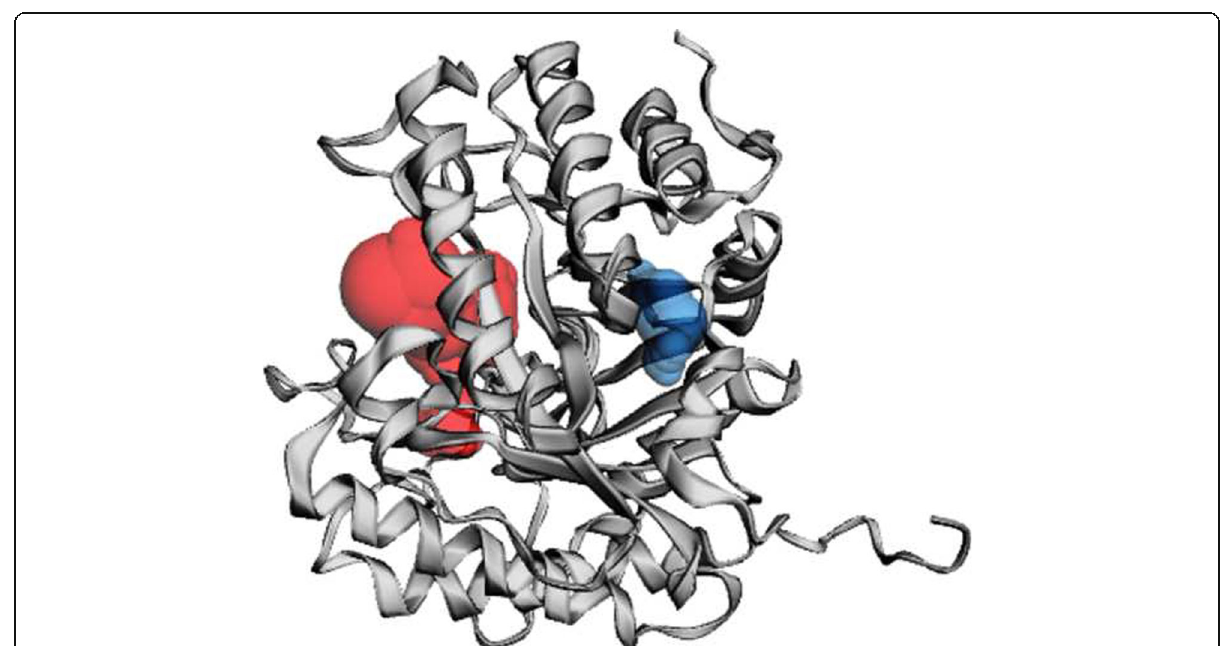
Fig. 9 CastP results showing surface accessible pockets as well as interior inaccessible